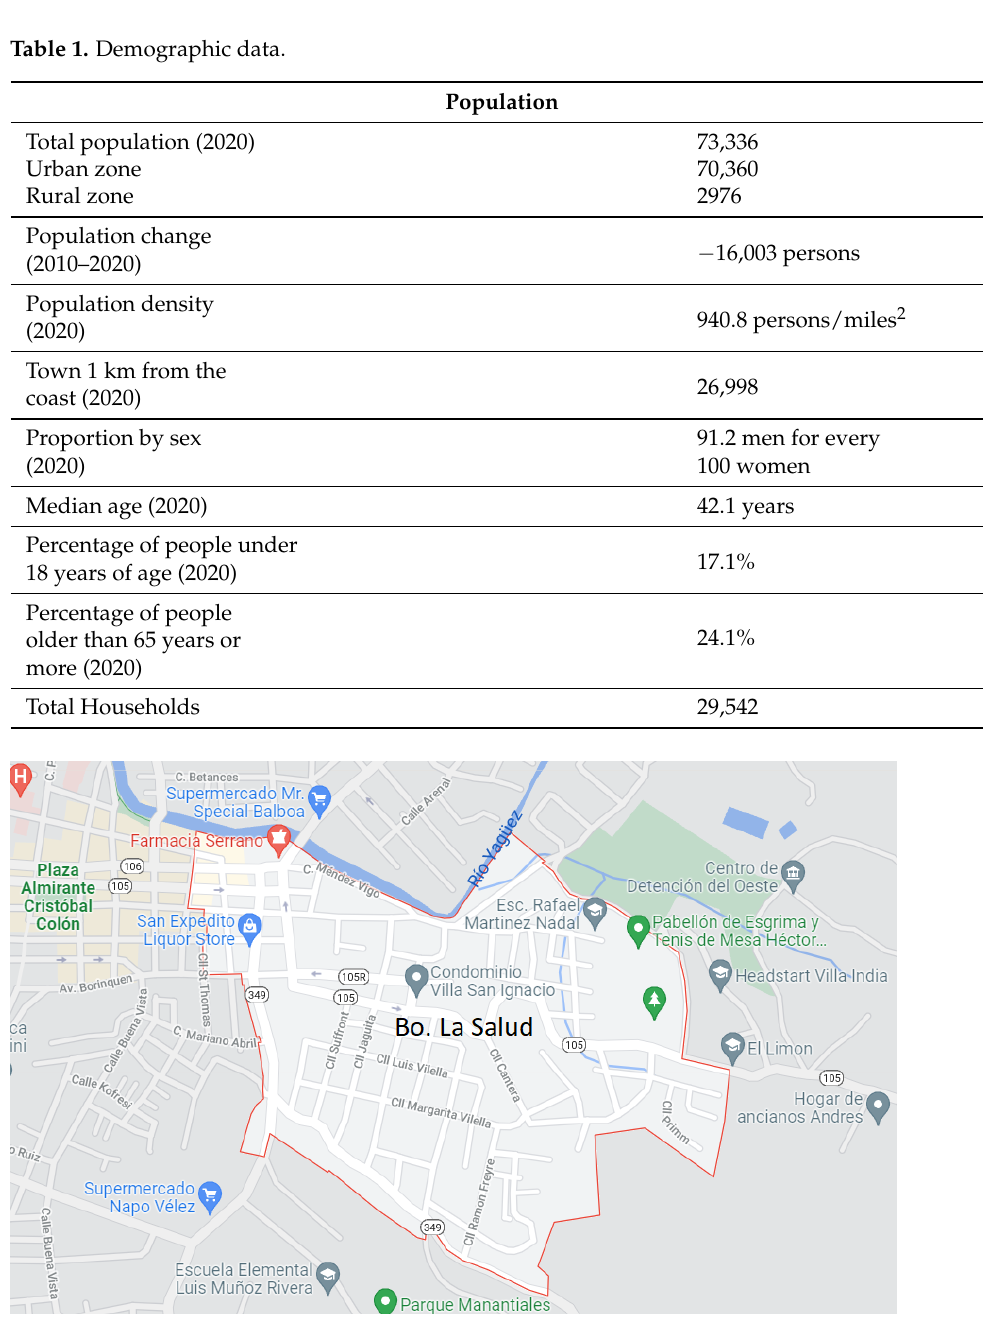
Figure 1. La Salud